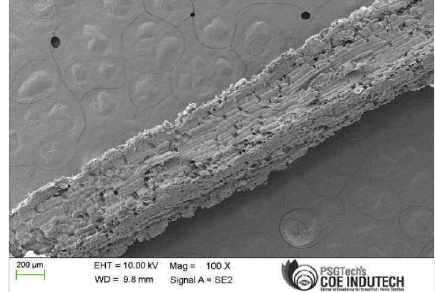
Figure 8: SEM images of KH570 modifed fber.